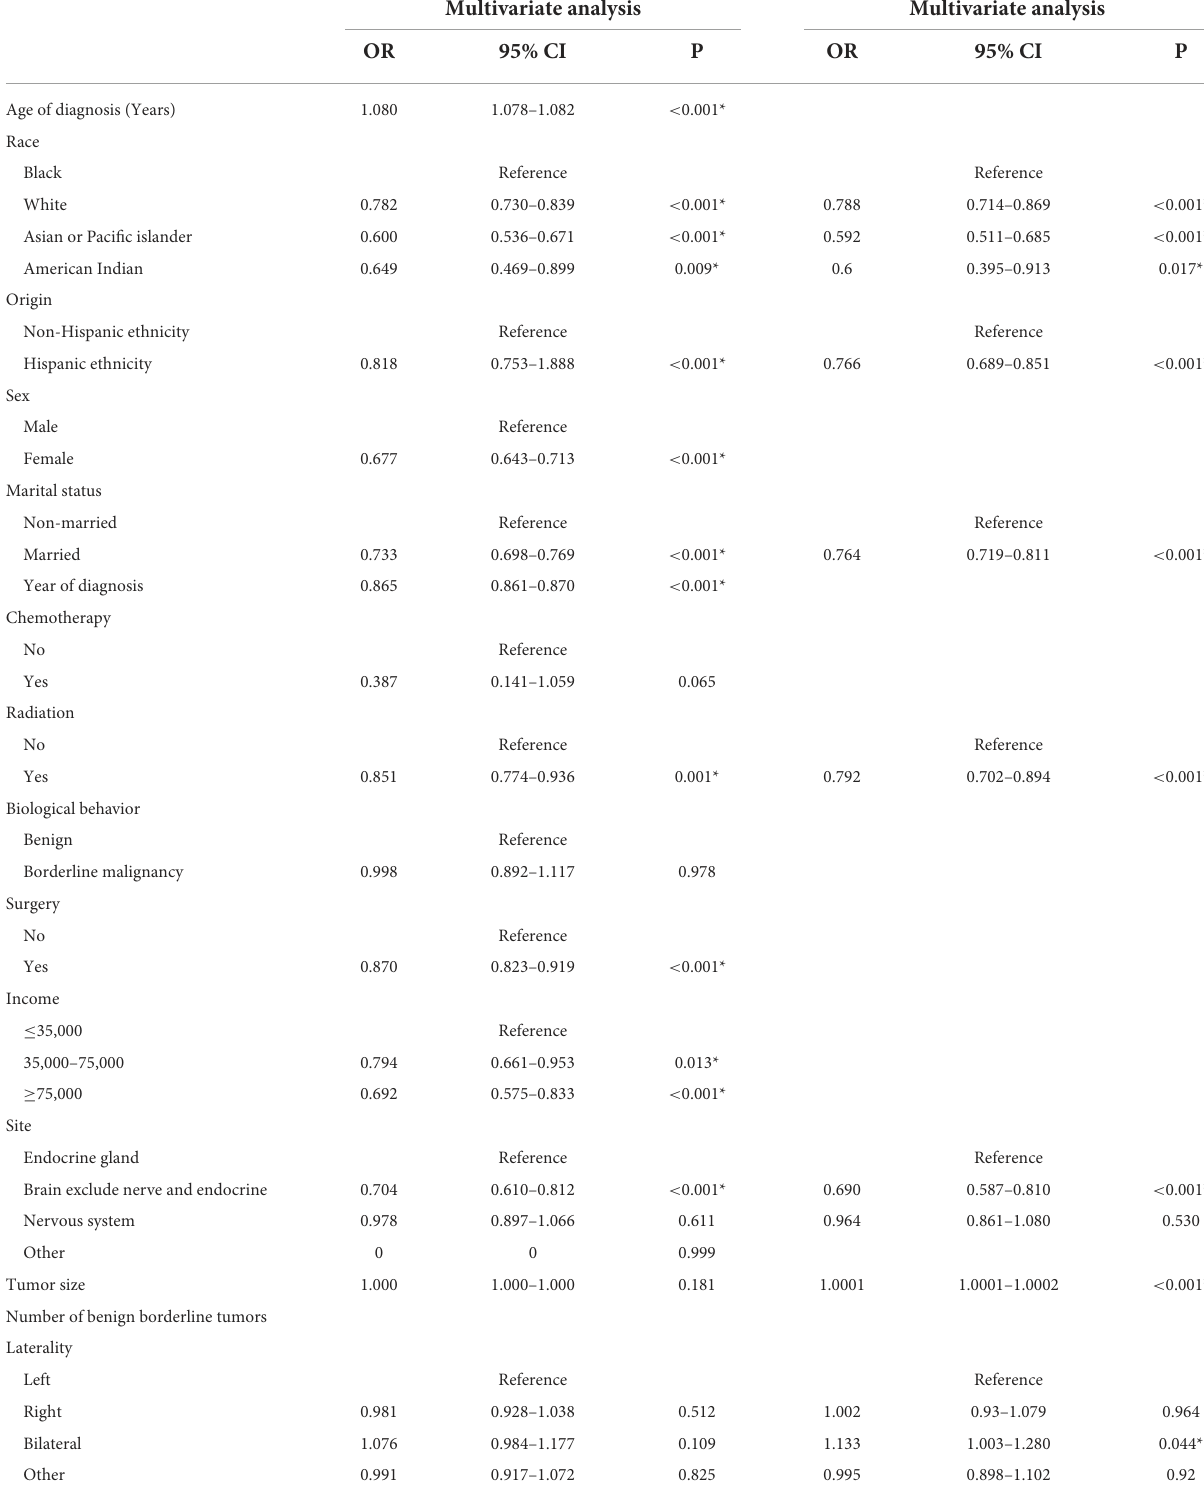
TABLE 3 Multivariate logistic regression analyses among patients with non-malignant tumors of CNS.